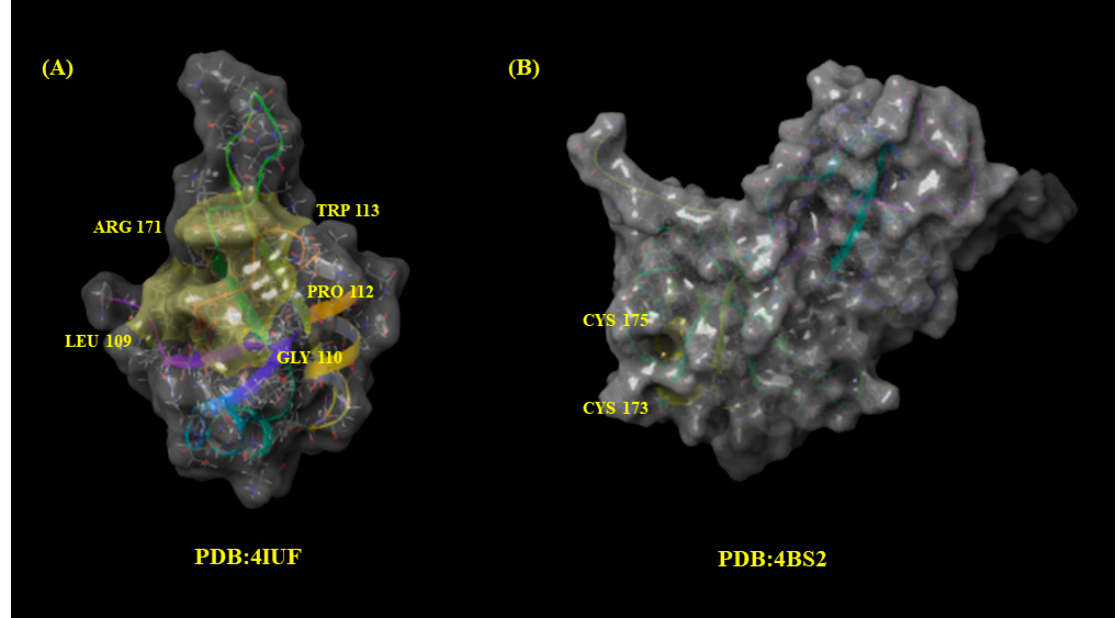
Figure 6. Binding pocket for TDP-43 crystalized protein 4IUF ( A ) and 4BS2 ( B ) with their respective catalytic residues are highlighted in yellow.